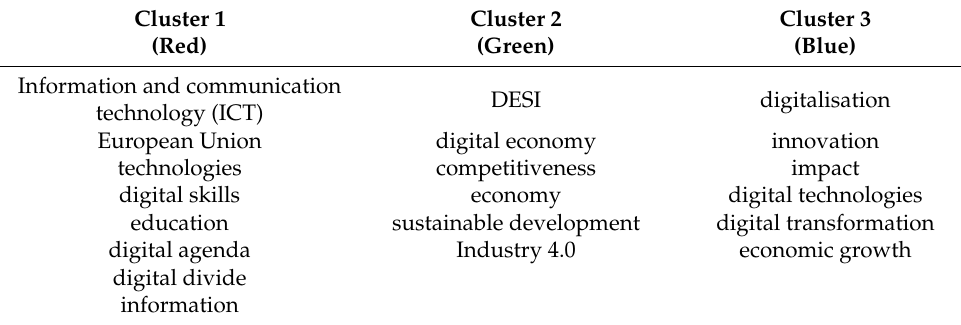
Figure 1. Keywords that meet threshold 5 in selected articles. Table 2. Keyword